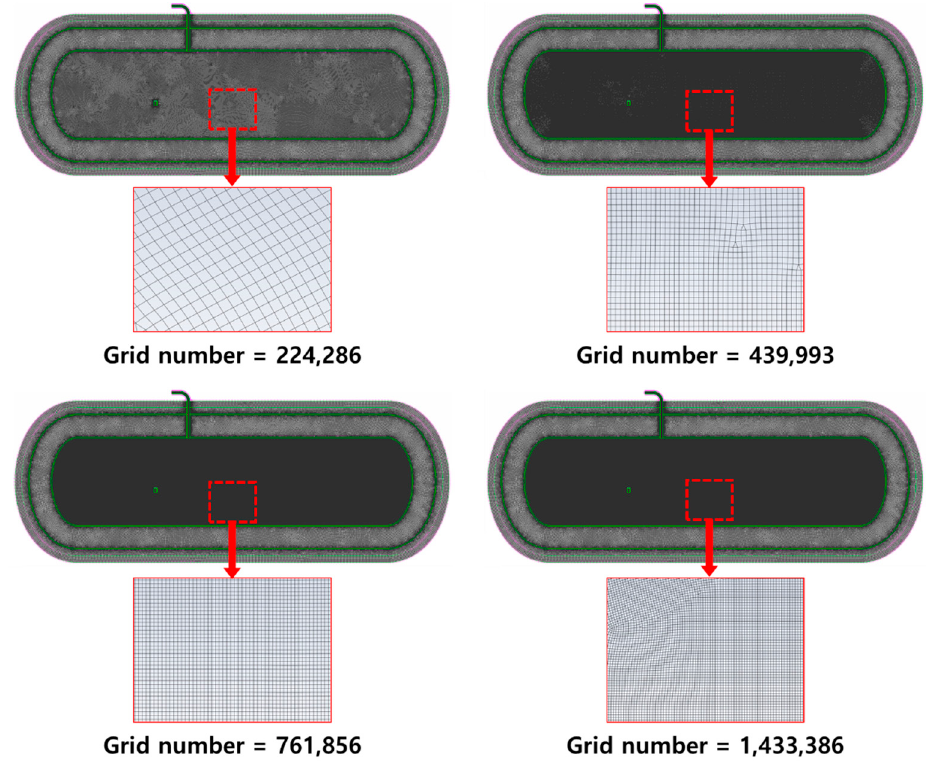
Figure 3. Grid characteristics of simulation domains.